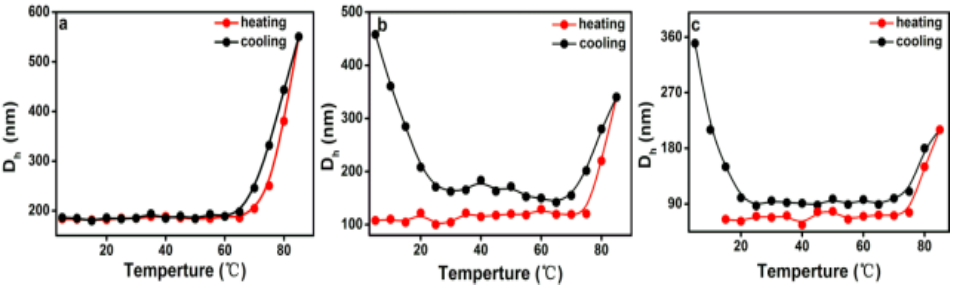
Figure 8. The variation of the hydrodynamic diameters ( D h ) as a function of temperature for various PEG-acrylic rosin polymer solutions in a heating and cooling run ( a : 2 g L − 1 , b : 0.5 g L − 1 , c : 0.01 g L − 1 ).